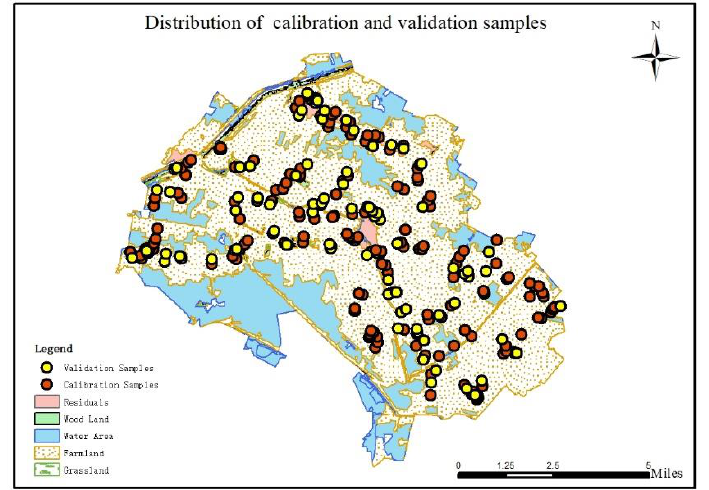
Figure 4. Calibration and validation samples selected utilizing the regional multi-variable associate rule mining and Rank–Kennard-Stone (MVARC-R-KS) method.